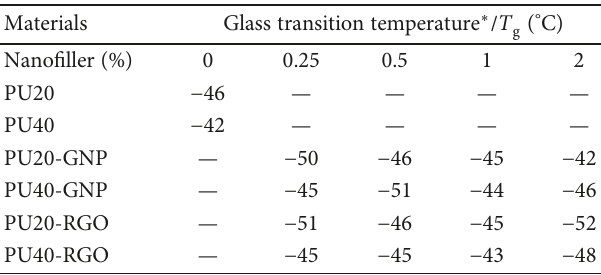
Table 4: Glass transition temperatures for PU and nanocomposite